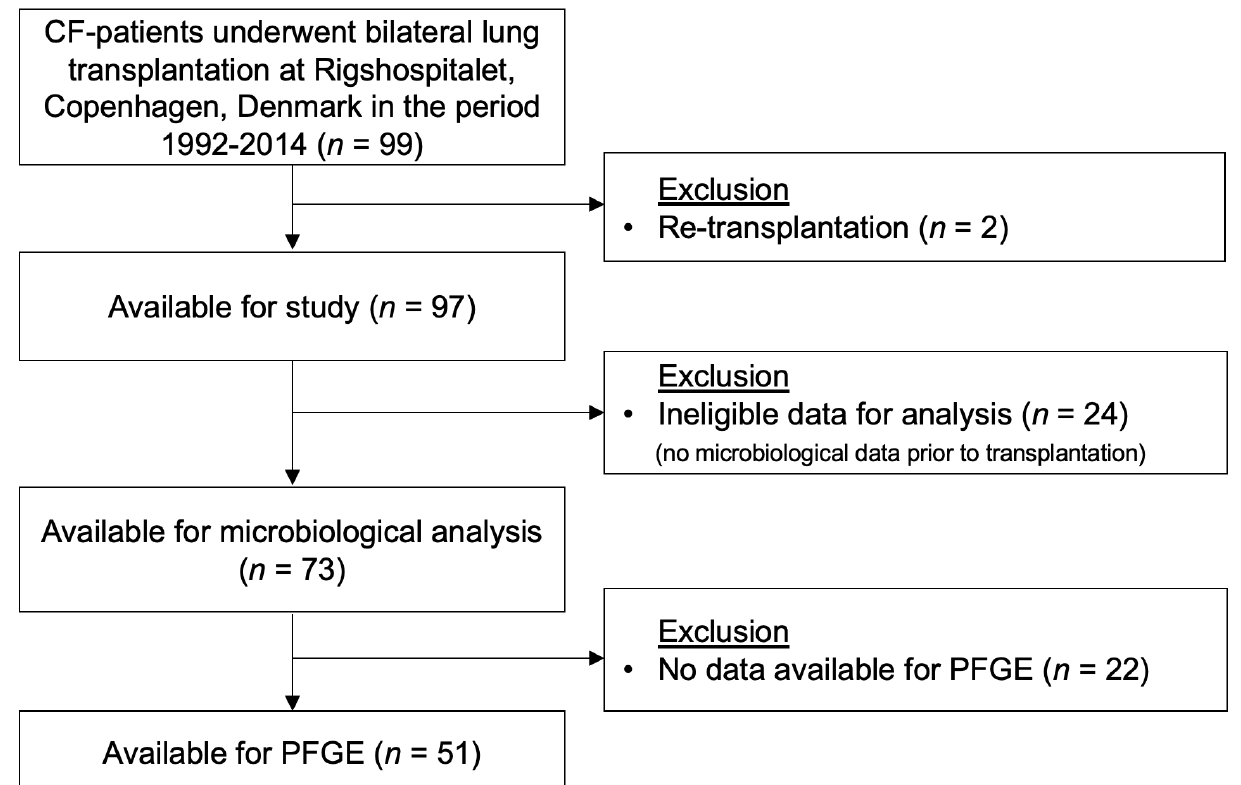
Figure 1. This diagram shows how patients were included and excluded in this study. Table 1. Demography of the patients including lung function at baseline and at chronic lung allograft dysfunction (CLAD). Variables are presented as median and standard